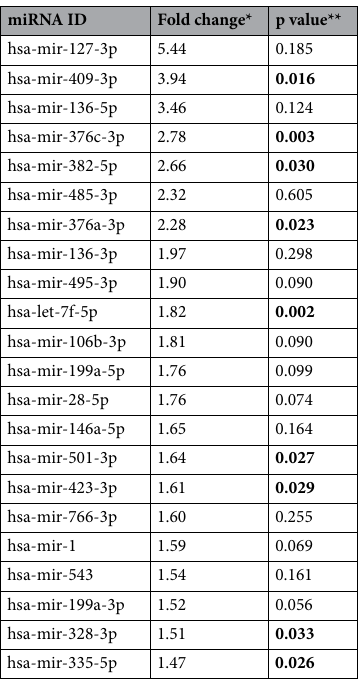
Table 2. Top microRNAs expressed in patients exposed to high levels of pollution. *Exposure to high pollution/low pollution, **Mann–Whitney U t-test, bold indicate p < 0.05.